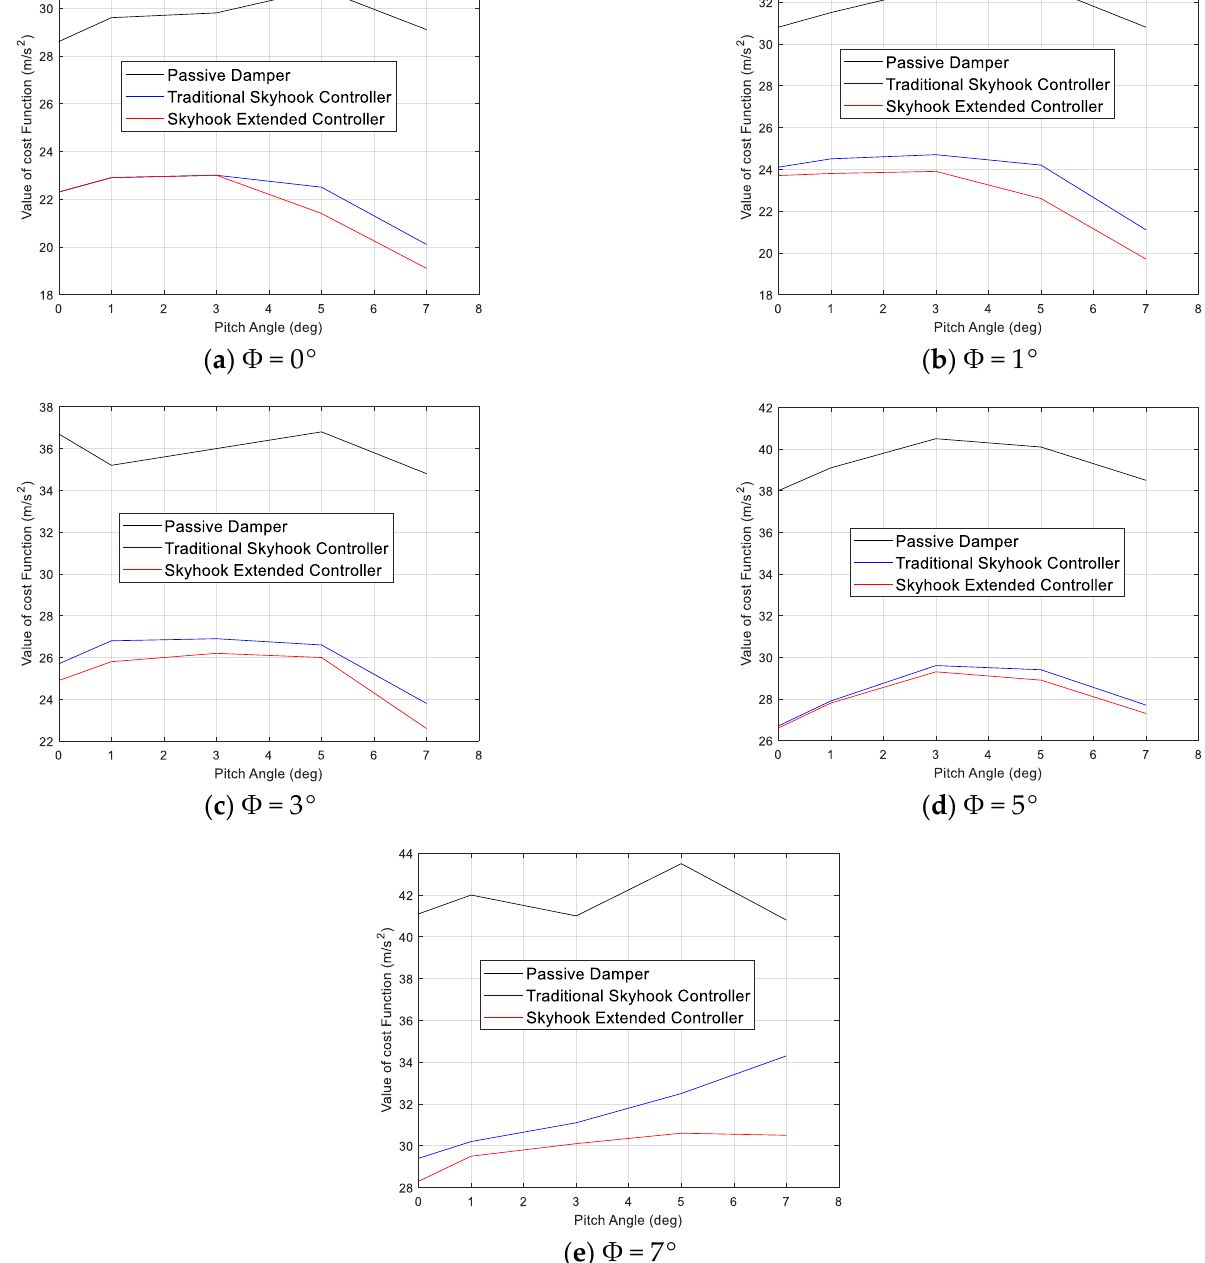
Figure 15. The value of cost function in differing pitch and roll angles.